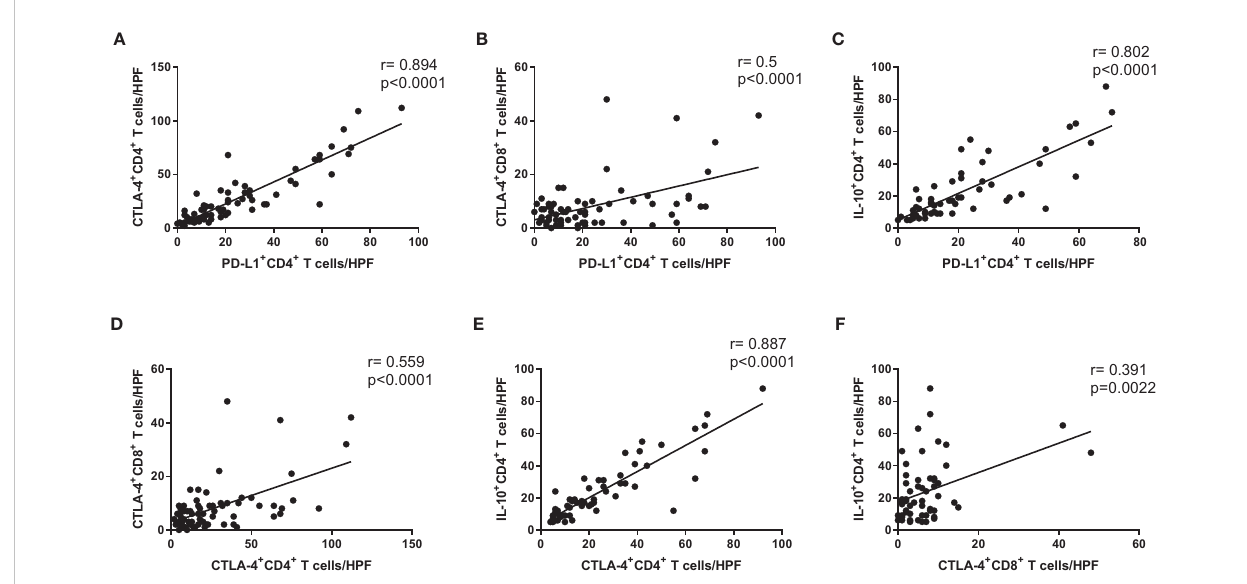
FIGURE 3 Expression levels of immunosuppressive markers on CD4 + and CD8 + T cells were correlated with each other in cancer tissue from GC patients. Correlation analysis of PD-L1 + CD4 + T cells with (A) CTLA-4 + CD4 + T cells, (B) CTLA-4 + CD8 + T cells, and (C) IL-10 + CD4 + T cells in cancer tissue from stage III cancer patients. Correlation analysis of CTLA-4 + CD4 + T cells with (D) CTLA-4 + CD8 + T cells and (E) IL-10 + CD4 + T cells in cancer tissue from stage III cancer patients. Correlation analysis of CTLA-4 + CD8 + T cells with (F) IL-10 + CD4 + T cells in cancer tissue from stage III cancer patients.